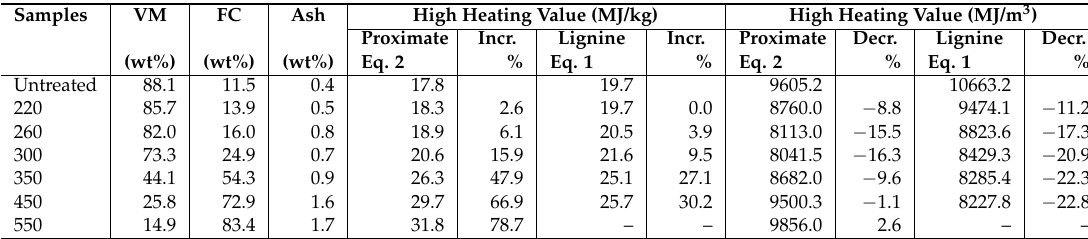
Table 4. Proximate analysis and high heating value changes of untreated and treated woods at each treatment